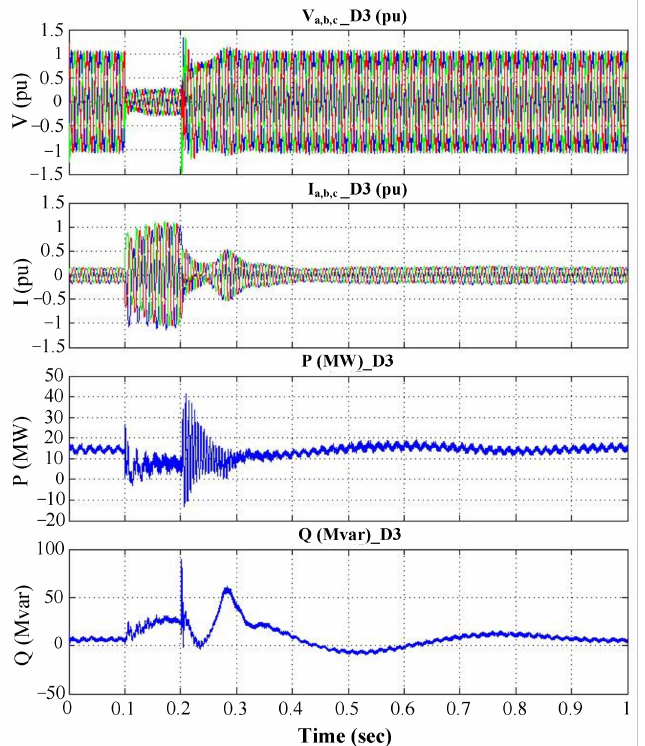
Figure 14. Responses of the D3 voltage, current, and real and reactive power for STATCOM installed at bus D3.